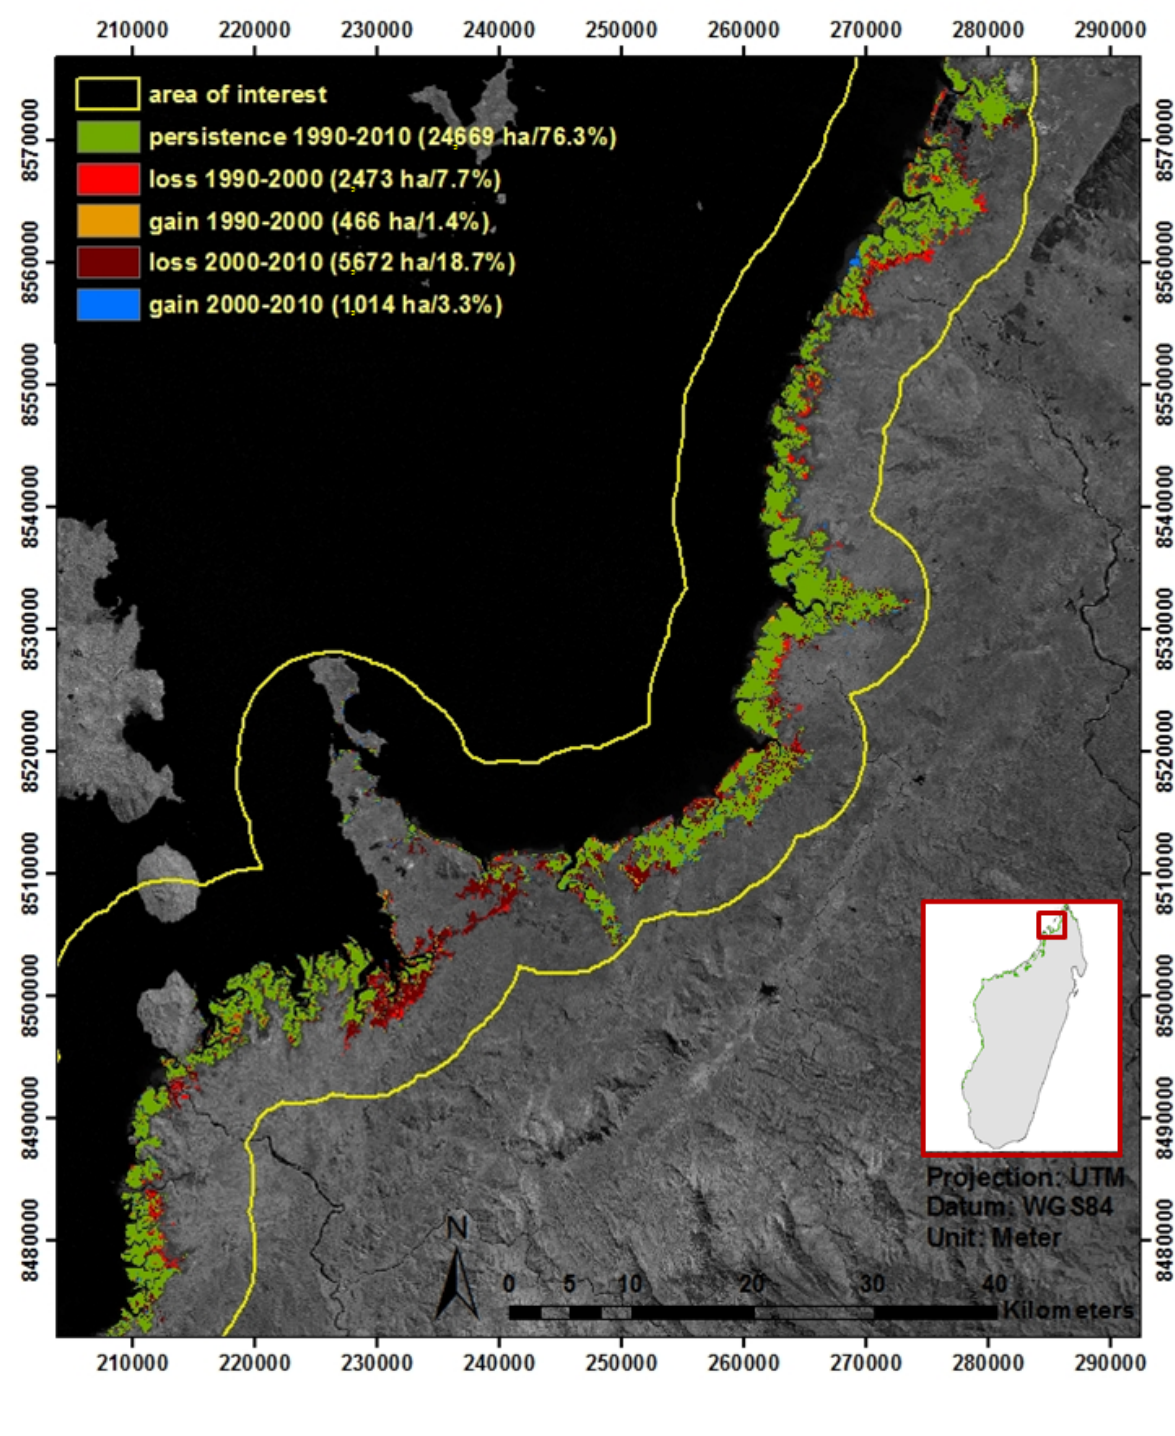
Figure 2. Mangrove dynamics from 1990–2000 and 2000–2010. Persistence, loss and gain were calculated using national-level mangrove maps produced by the United States Geological Survey